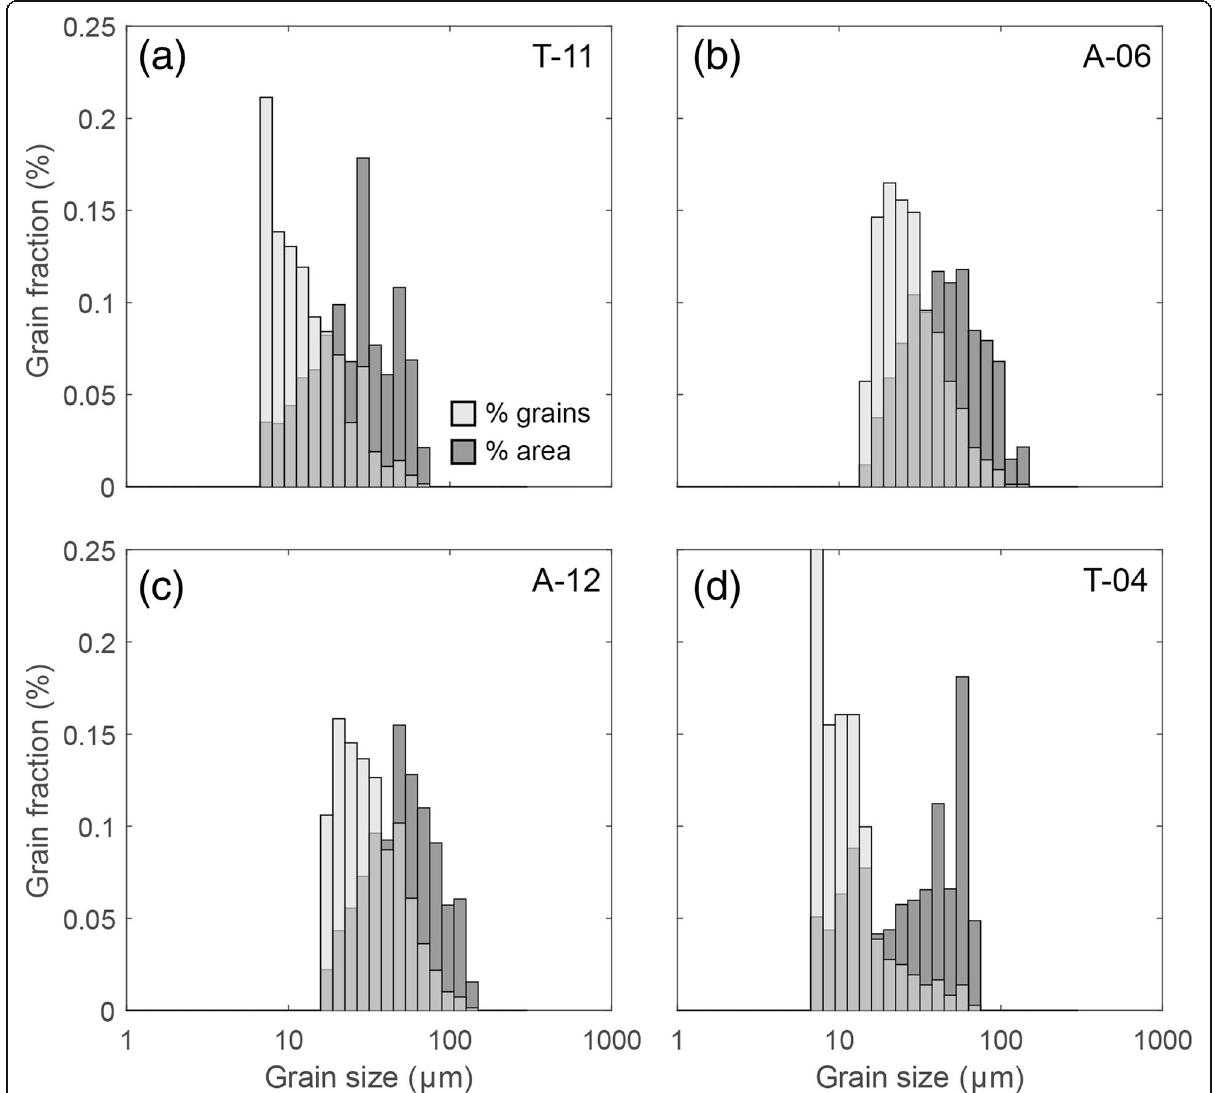
Fig. 12 Grain size distribution histograms for recrystallised grains in protomylonite samples from Tsukide ( a and d ) and Ako-Miyamae ( b and c ). Area fractions are included to account for the bias toward small grains created during grain